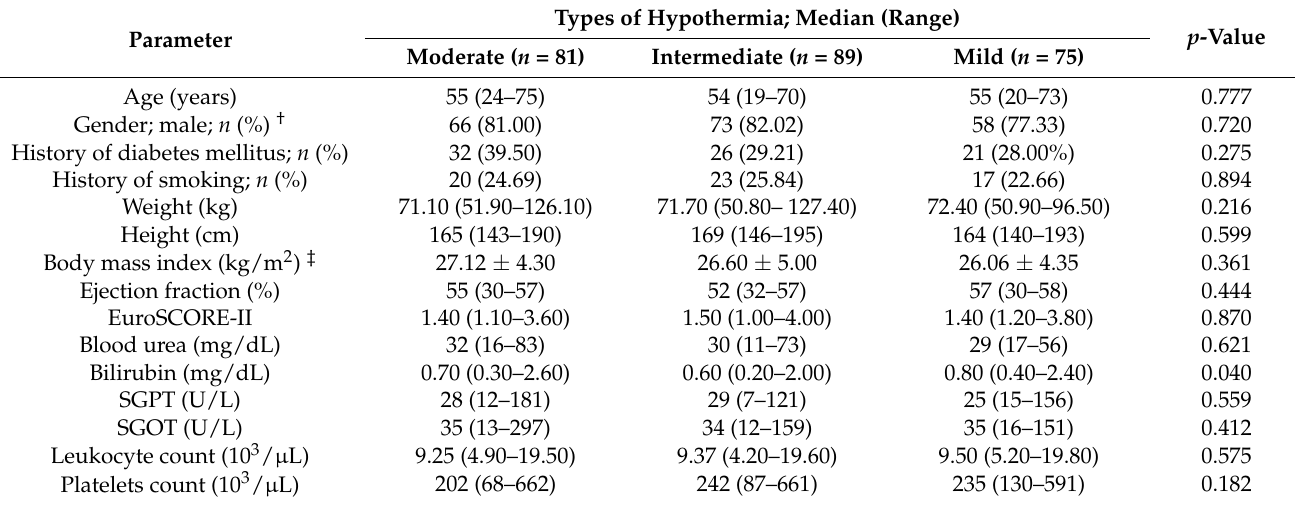
Table 2. Baseline characteristics of patients undergoing cardiopulmonary